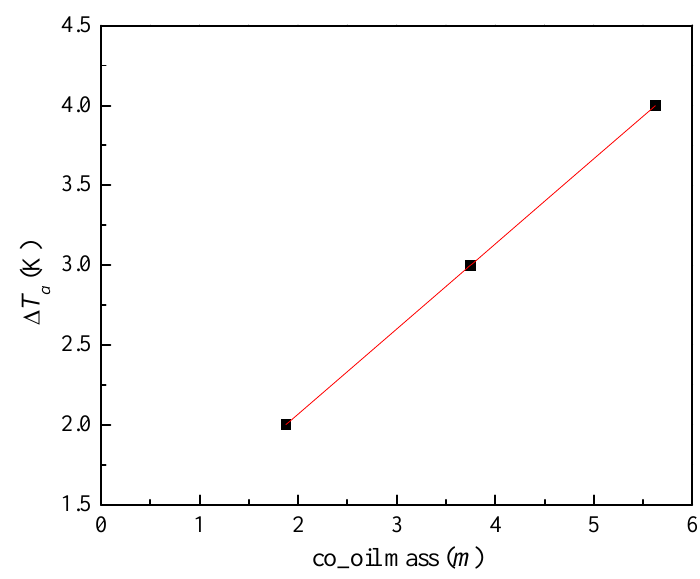
Figure 10. Air temperature decrease as a function of co_oil mass and the linear fit by Equation (5).